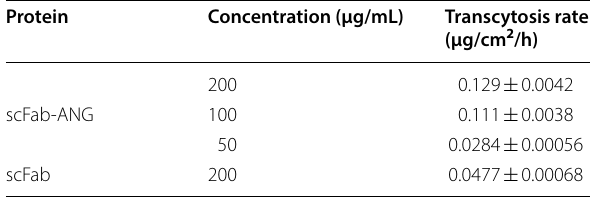
The concentrations of scFab-ANG and scFab in lower chambers were measured every 30 min. Transcytosis curve was generated, X-axis was time, Y-axis was transcytosis. Transcytosis rate was calculated as curve slope